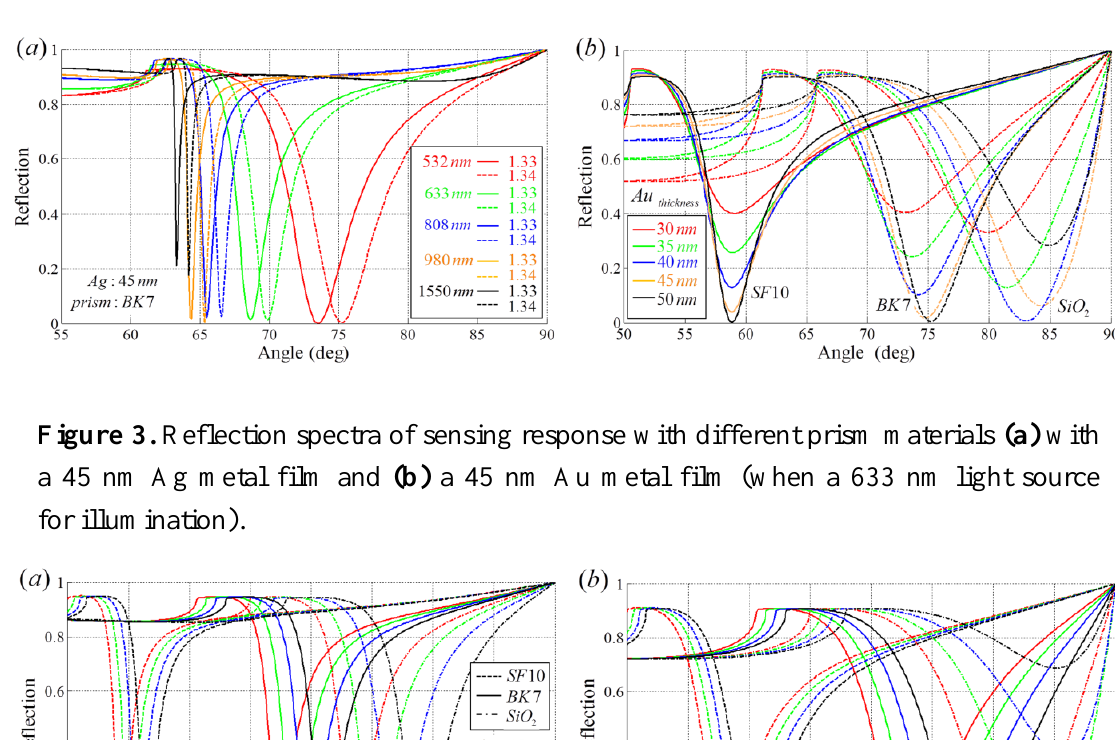
Figure 2. Reflection spectra of a Kretschmann configuration based SPR sensor (a) depending on the wavelength of the monochromatic light source with a BK7 prism